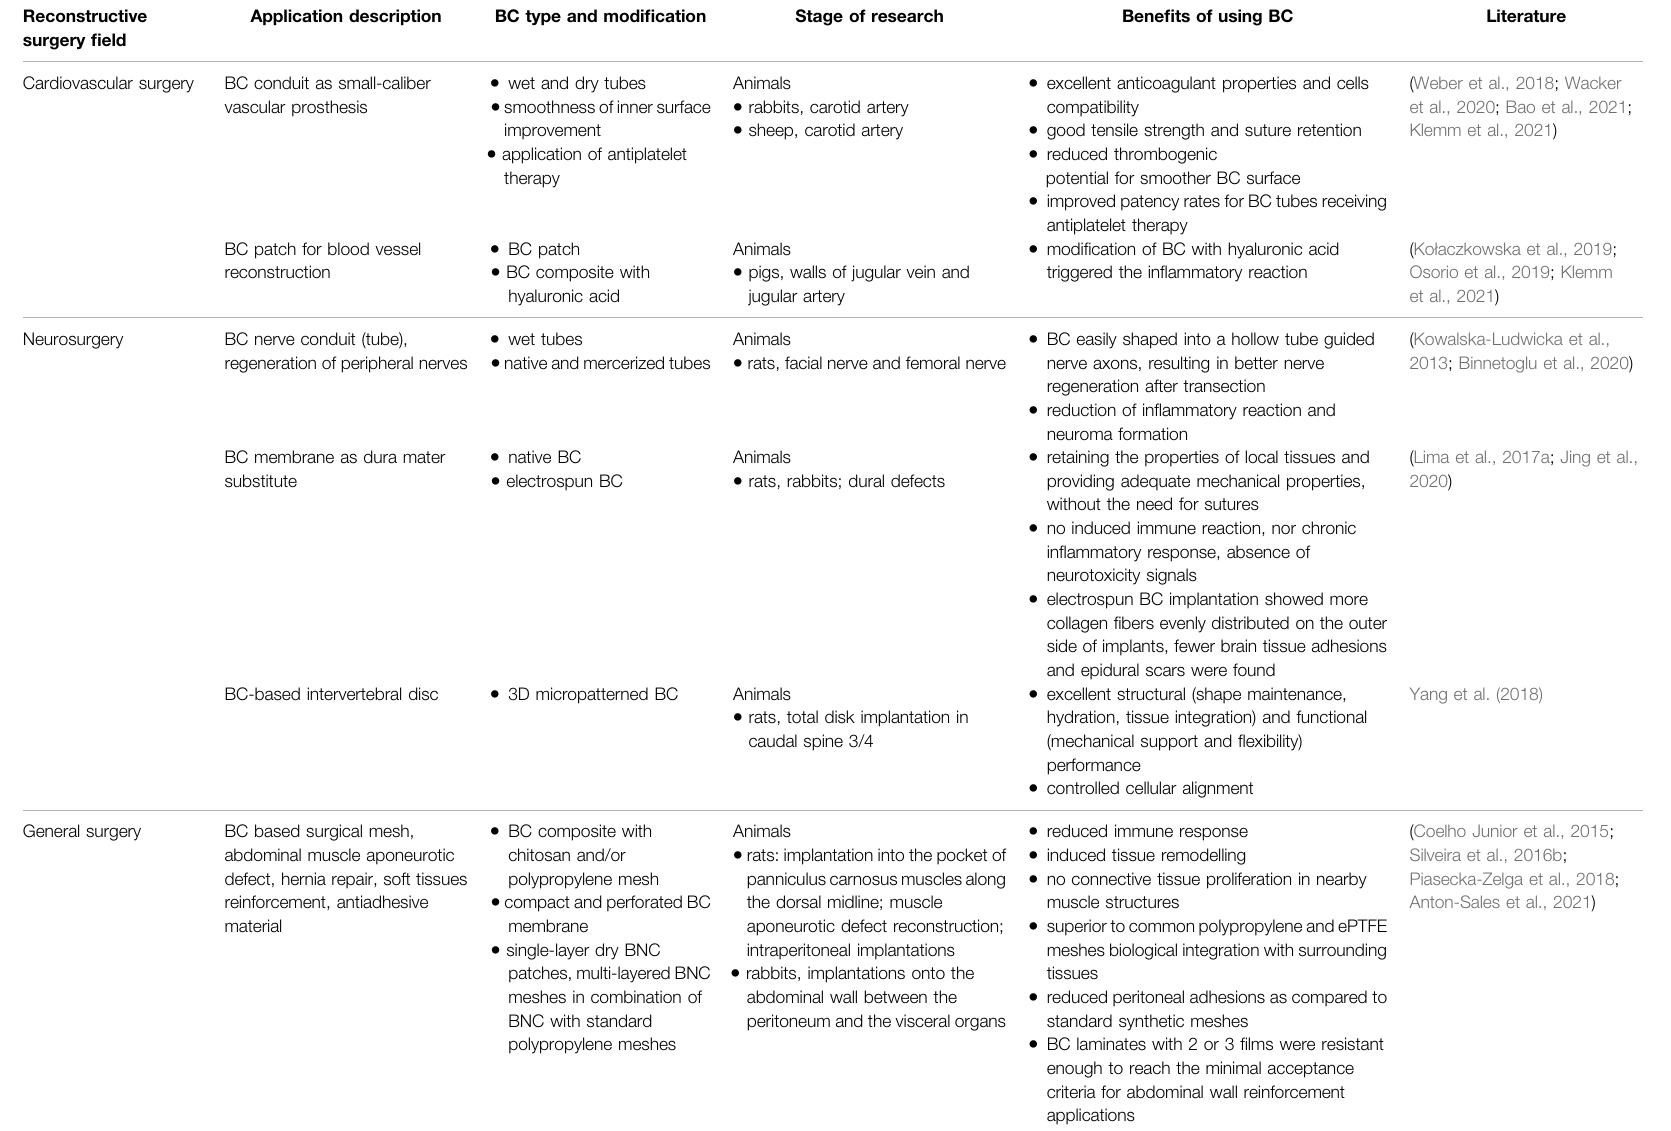
TABLE 2 | Examples of applications of BC implants in reconstructive